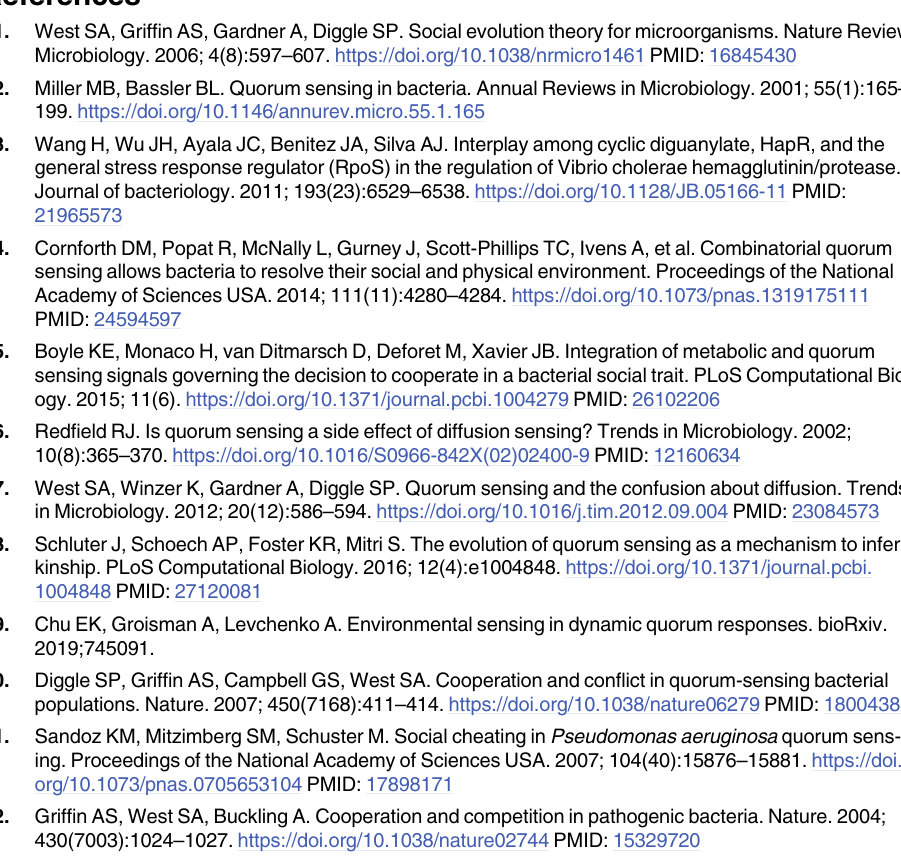
S1 Table. Model parameters used in main text figures. S2 Table. Model parameters used in supplemental